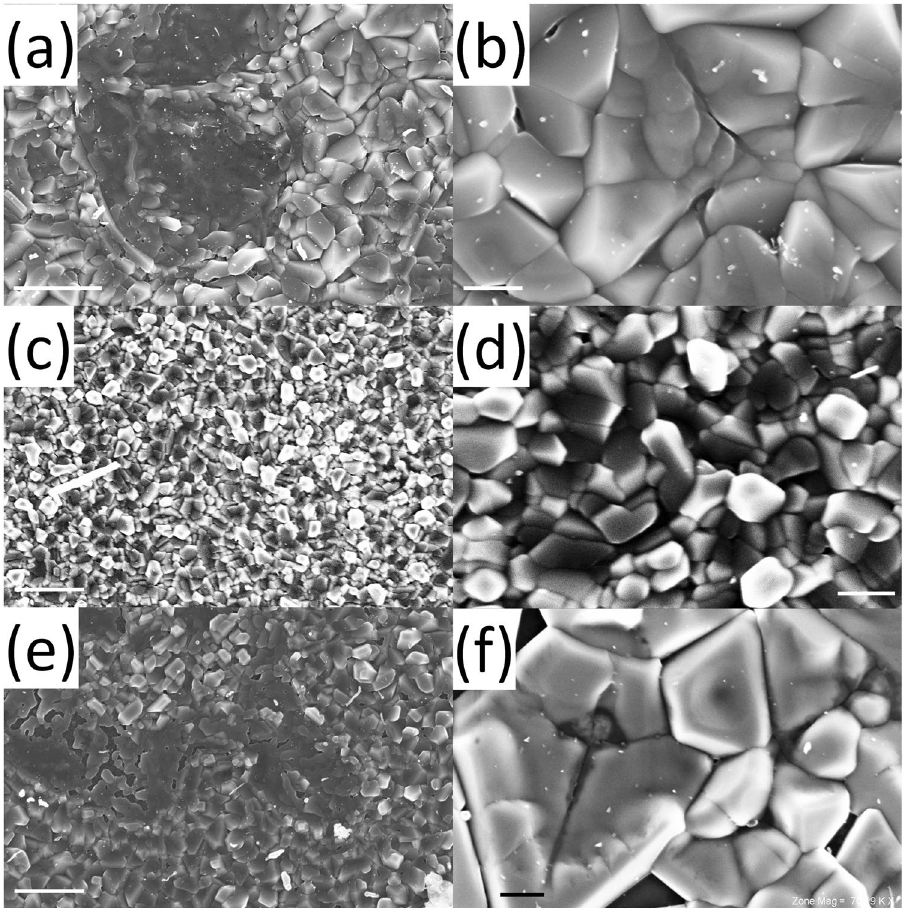
Figure 1. DNA film structure. Scanning electron micrographs of ( a,b ) a 0.0031 mg/mm 2 surface density DNA film exposed only to ambient UV light, ( c,d ) a 0.0031 mg/mm 2 DNA film irradiated with a dosage of 320 J/ cm 2 UVA light (365 nm), and ( e,f ) a 0.0031 mg/mm 2 DNA film irradiated with a dosage of 320 J/cm 2 UVB light (302 nm). Scale bars in the left and right columns of images respectively denote 2 μ m and 400